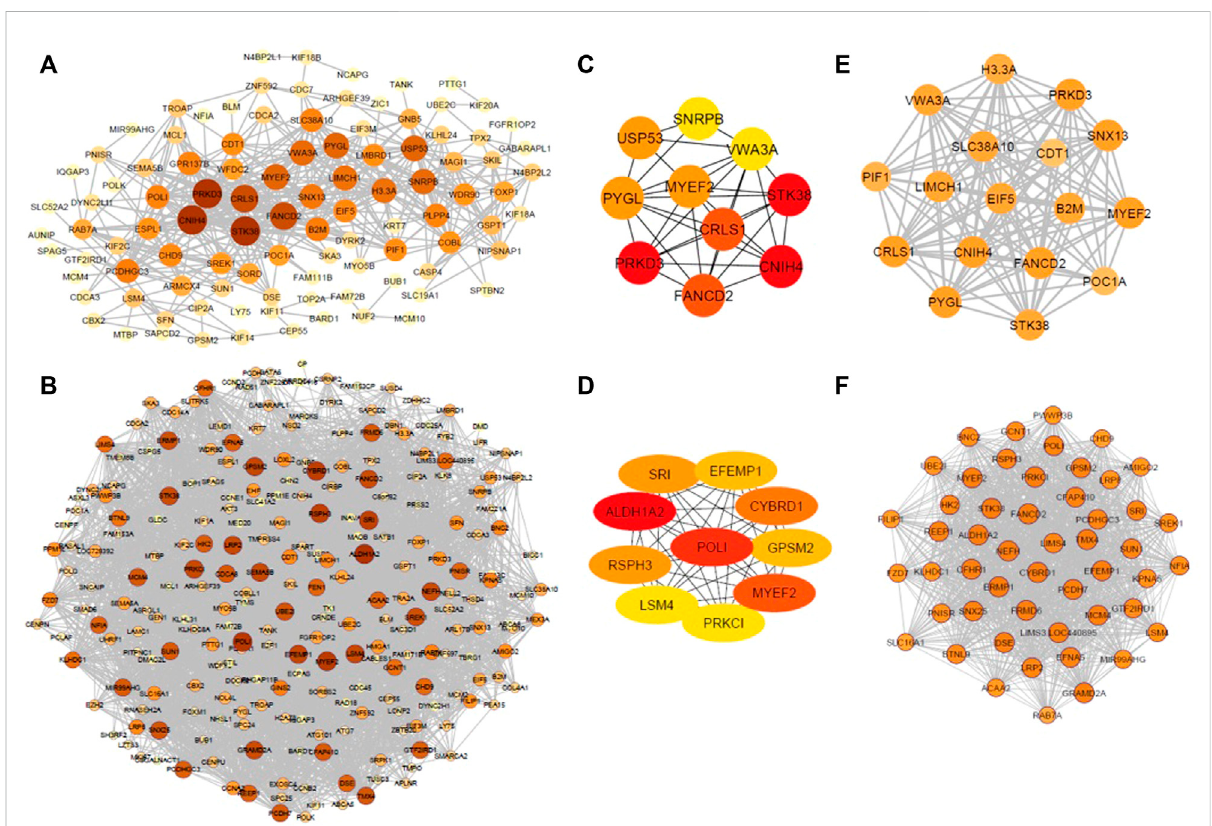
FIGURE 3 (A) OC, constructed around the signi fi cantly co-expressed gene pairs in the diseased state. (B) non-OC, constructed around the signi fi cantly co-expressed gene pairs in healthy state. (C) Hub genes of OC. (D) Hub genes of non-OC. (E) Top-scoring module of OC module (OCM). (F) Top- scoring module of non-OC. Size and colors of nodes were determined according to node